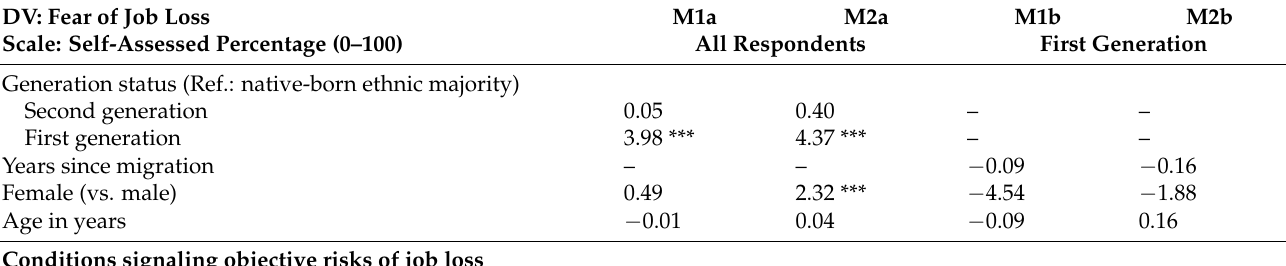
Table 1. Linear regressions, fear of job loss, 2020/2021.